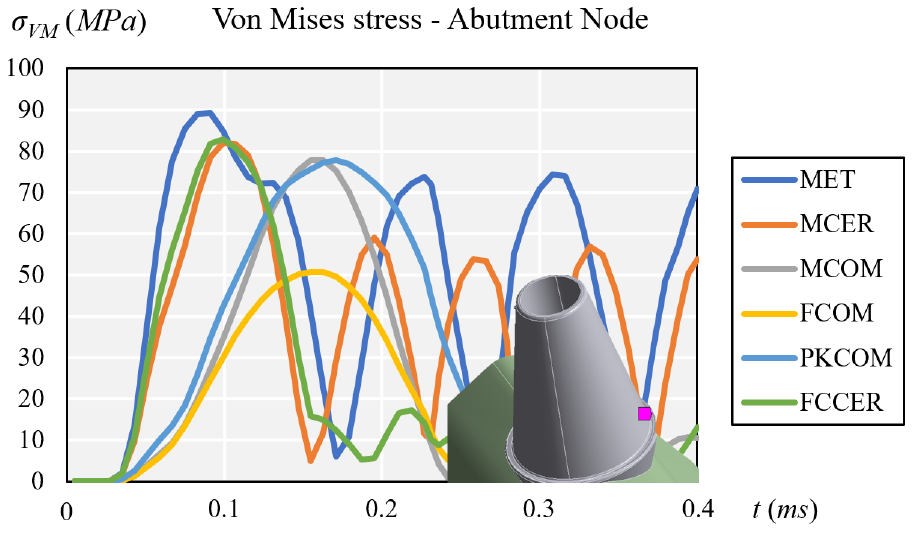
Figure 5. Comparison of equivalent von Mises stress at the titanium abutment node.